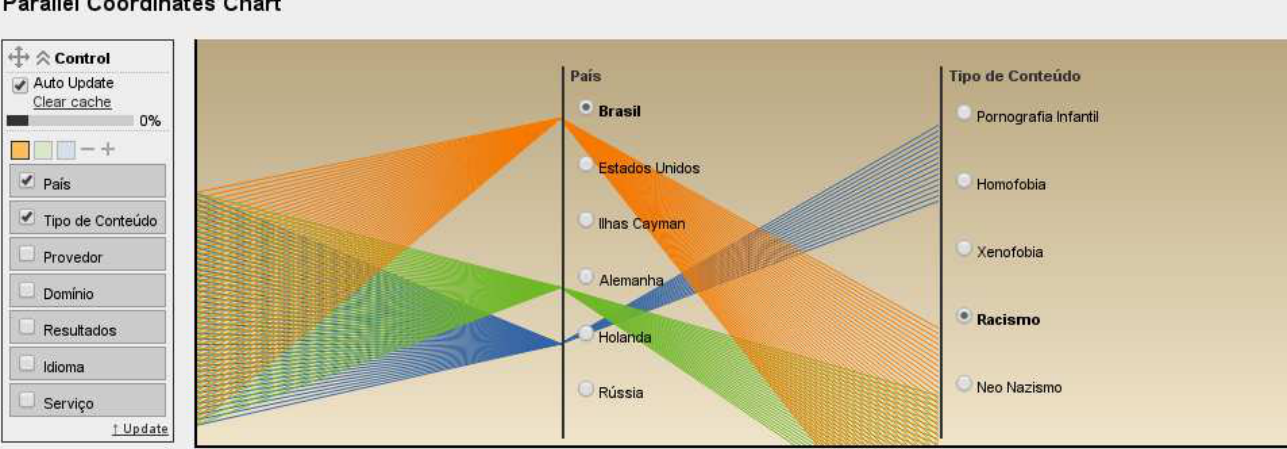
Fig. 8. Parallel coordinates: fixed-width lines for each element of the input